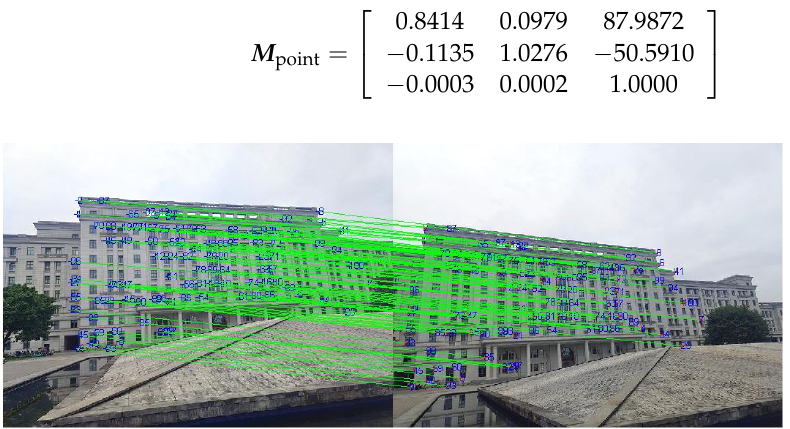
Figure 10. The stitched image generated by using M ab .